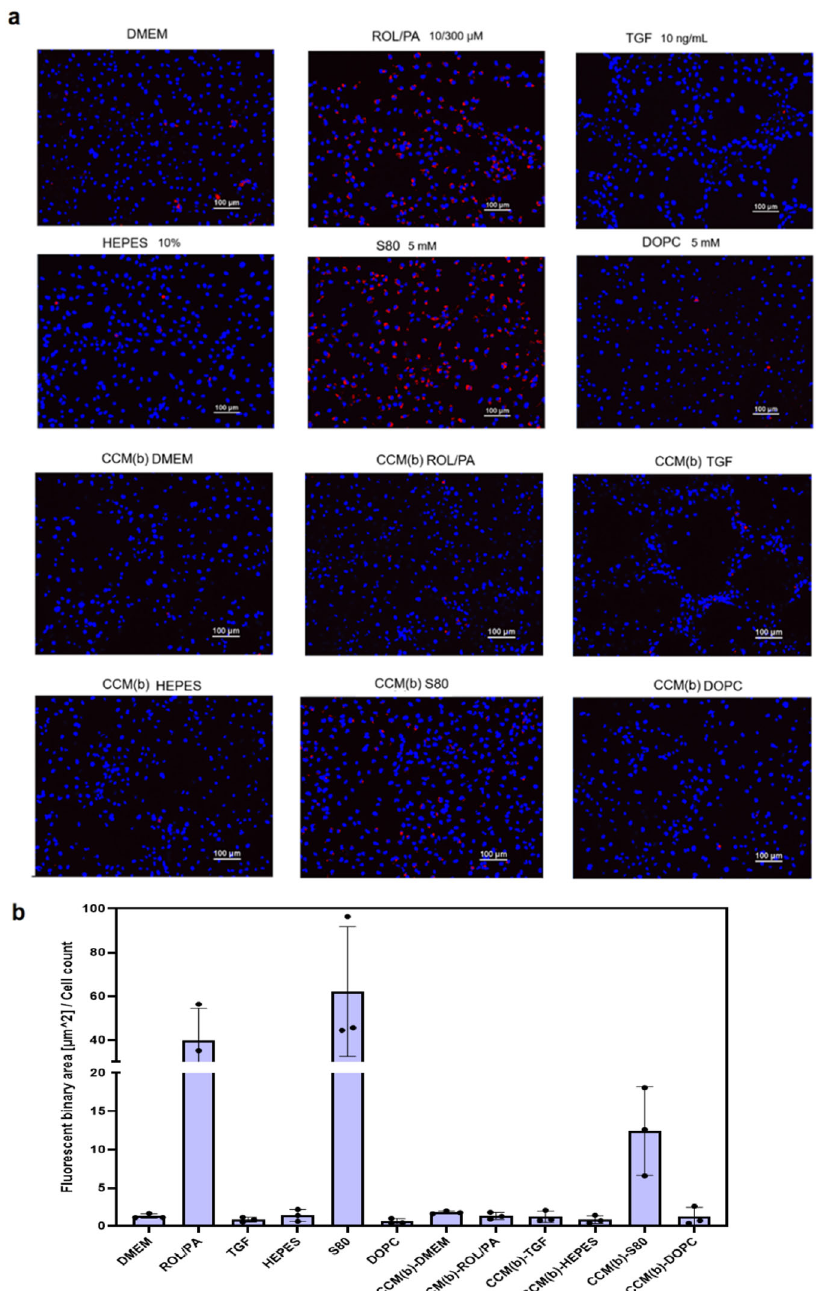
Fig. 3 Treatment of fresh LX-2 with EV-pellets from previously treated cells. a Representative images of ORO staining in fl uorescence (seen as red spots; nuclei stained with blue DAPI) of differently treated cells after thresholding (see Fig. S3). b Quantitative analysis of stained lipid droplets, whereby the fl (mean ± SD, n = 3). For more results, see Figs. S4 –